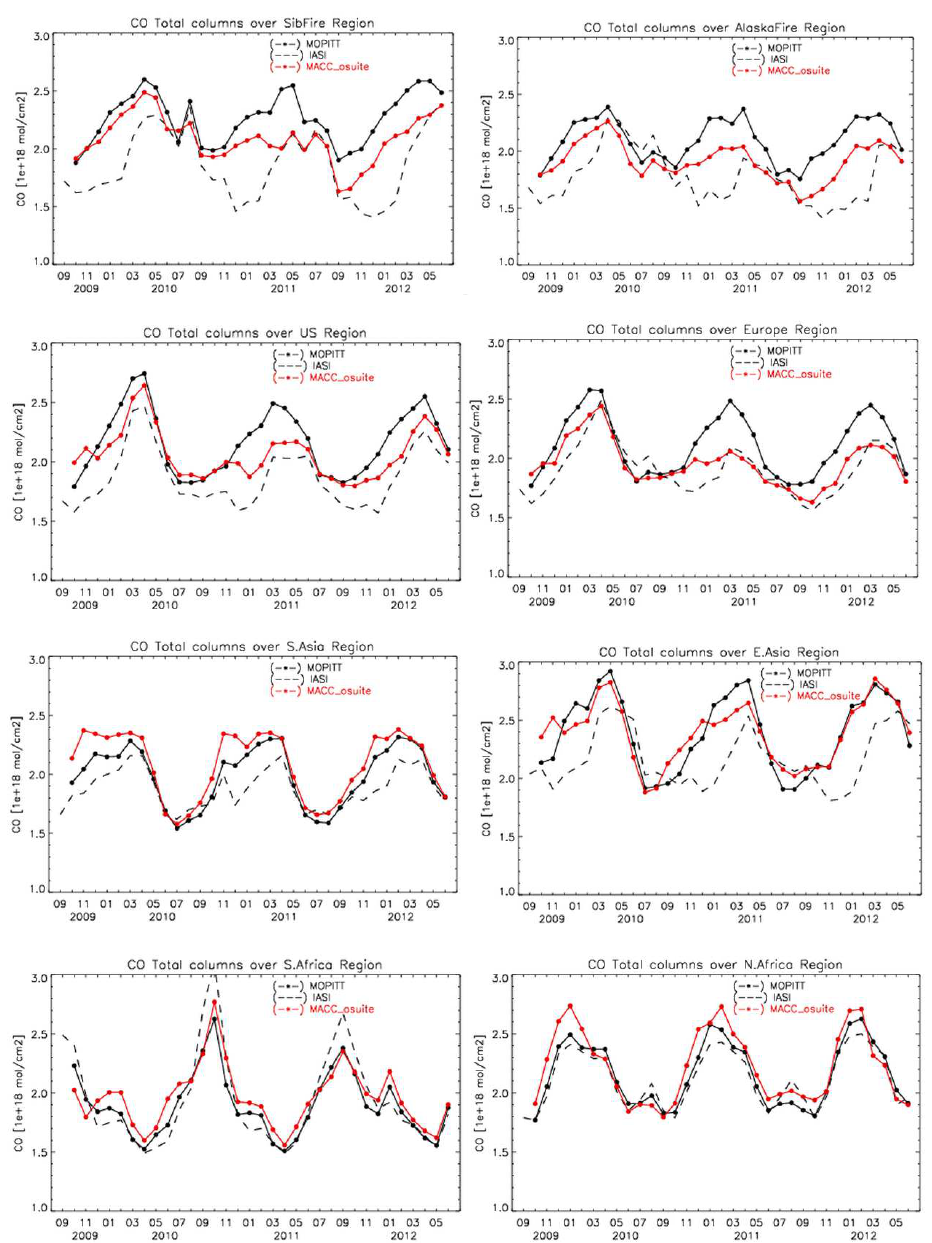
Figure 14. Time series plots of MOPITT CO total columns (black line) compared to IASI CO total columns (black dashed line) and the MACC_osuite CO total columns (red line) for eight different regions (defined in Fig. 1) during the period September 2009 to June 2012. Top: Siberia (left), Alaska (right), second row: United States (left), Europe (right), third row: South Asia (left), East Asia (right) bottom: southern Africa (left), North Africa